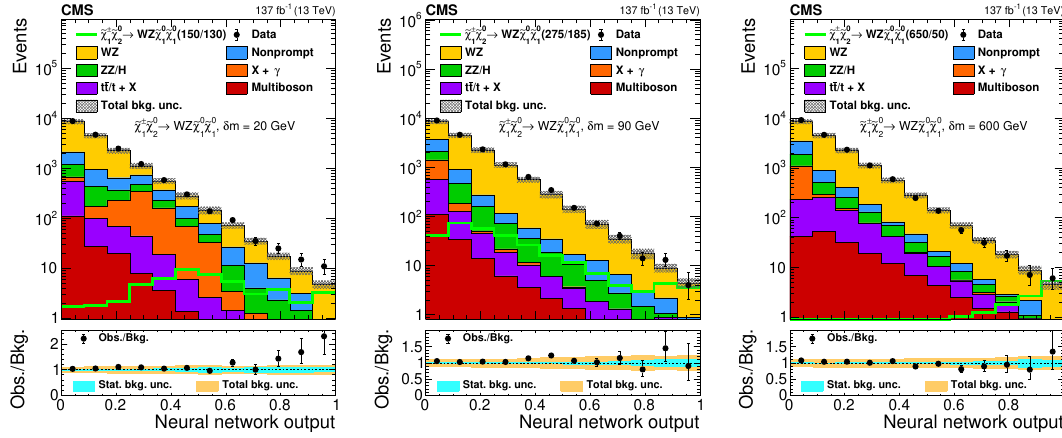
Figure 5 . Observed and expected yields as functions of the output of the neural network used to ± 0 search for production with WZ -mediated decays, evaluated at δm = 20 GeV (left), 90 GeV e c 2 1 e c (center), and 600 GeV (right). The legends specify the masses of distributions as ( m / m ). The top panels show only the total uncertainty in the background 0 0 e c e c 2 1 prediction, while the lower panels show the total and statistical uncertainties separately. The following abbreviations are used in the legends of this and the following figures: “bkg.” stands for background, “unc.” for uncertainty and “obs.” for